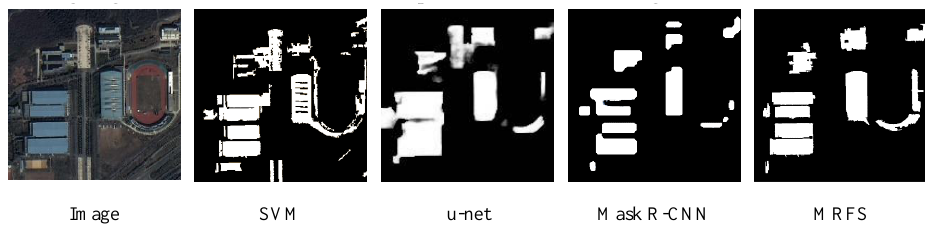
Figure 12. Building extraction result maps of different methods.